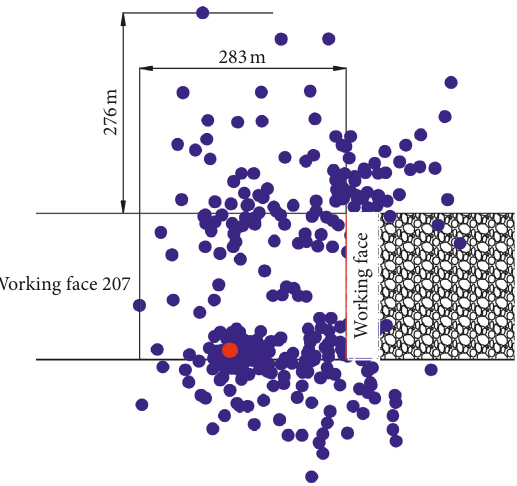
Figure 11: Locations of microseismic events relative to working face 207.